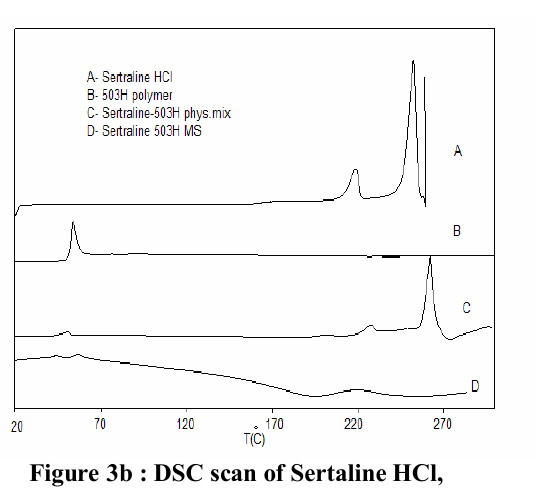
Figure 3a : DSC scan of Sertaline HCl, Sertaline HCl-502H polymer physical mixture, 502H polymer and Sertaline HCl 502H microspheres.